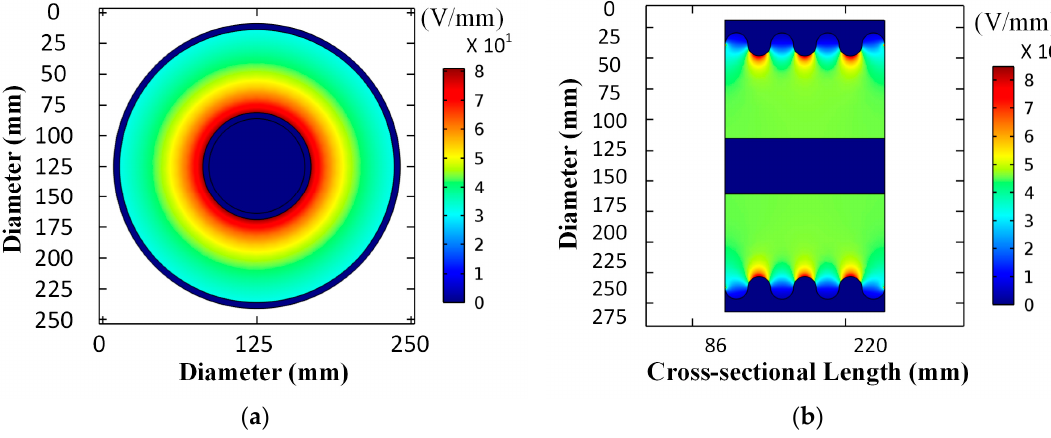
Figure 3. Electric field comparison of: ( a ) Conventional GIL; ( b ) Flexible GIL (Pitch = 38 mm).